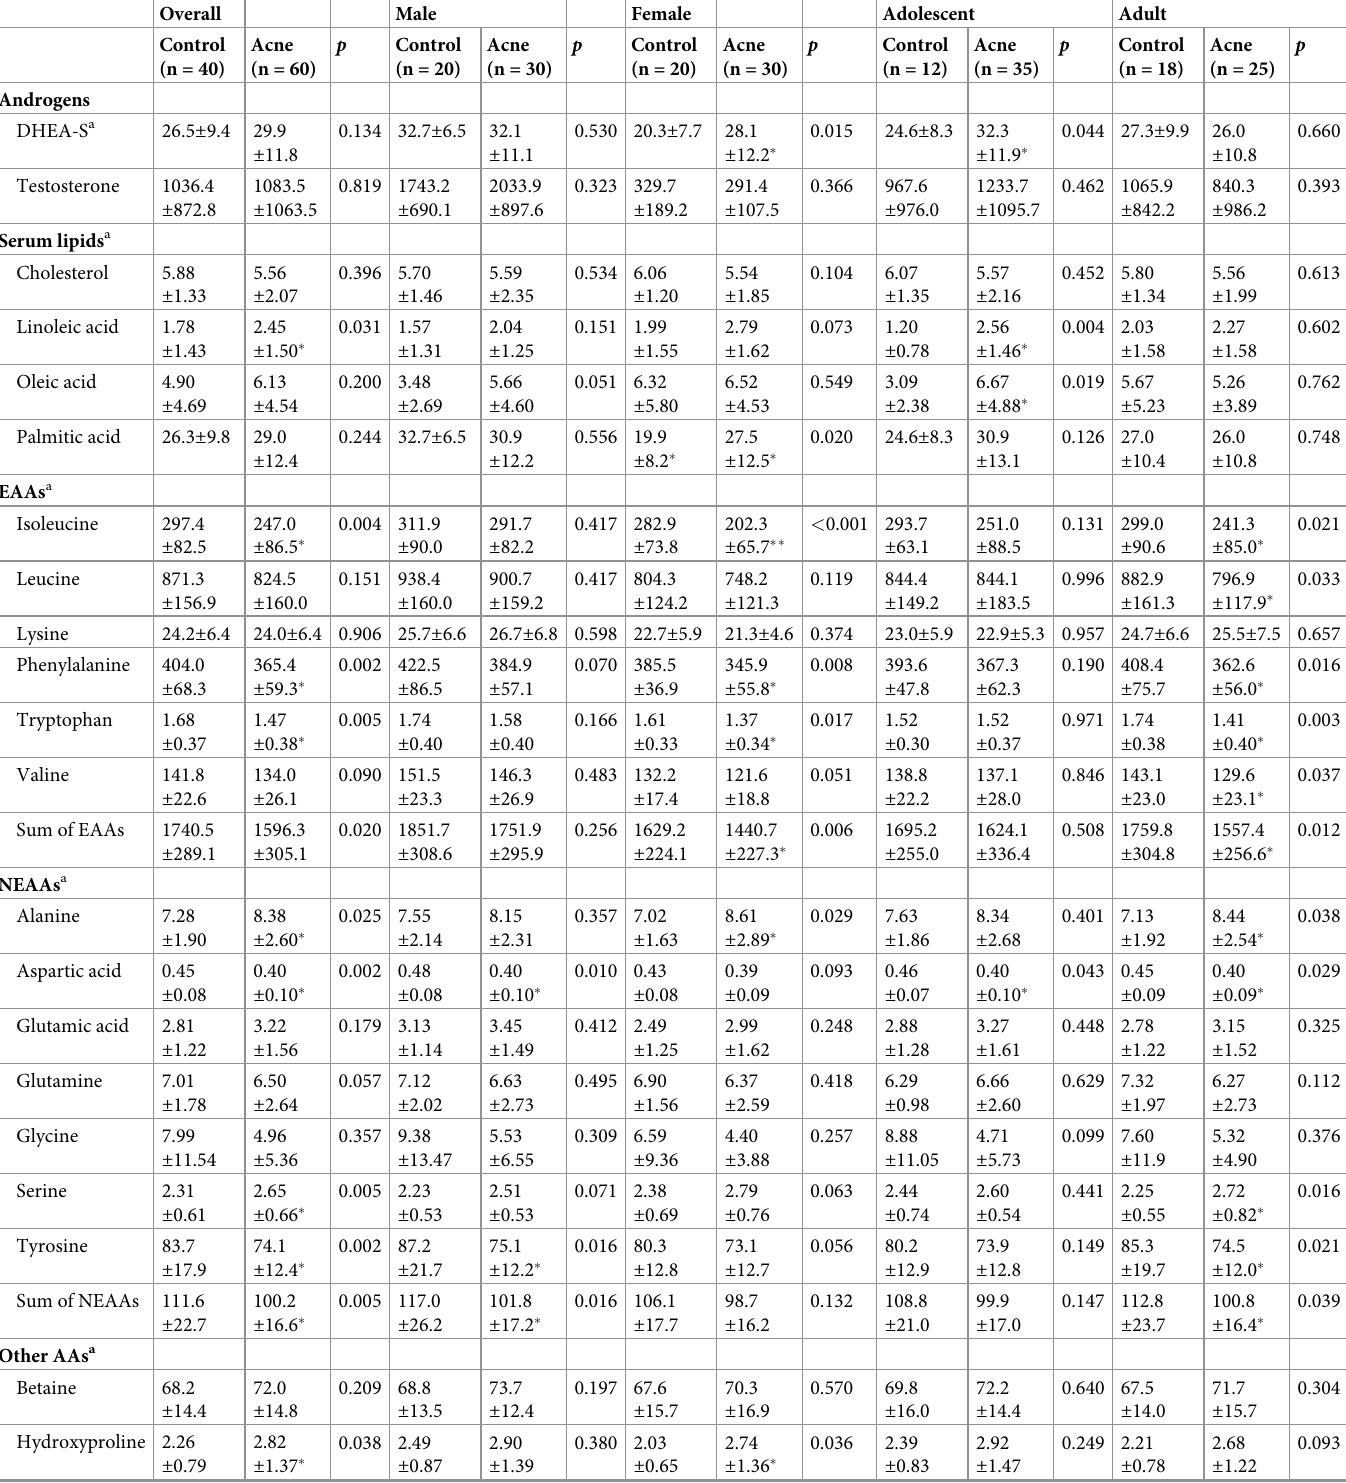
Table 4. Comparison of metabolomic profiles with pro-inflammatory cytokines between